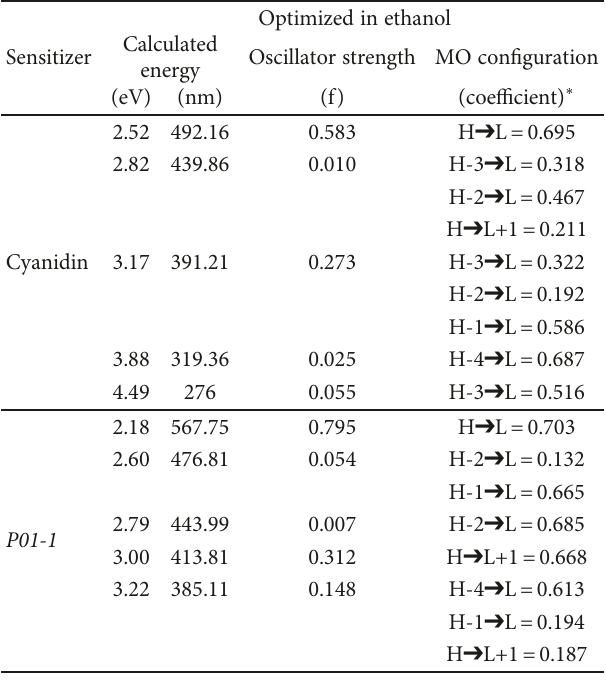
Table 2: Computed excitation energies in (eV), (nm), and the oscillator strength (f) of the cyanidin and P01-1 obtained by TDDFT calculations at B3LYP/6-31g (d) level with the inclusion of geometry optimization under the solvation e ff ect of ethanol.